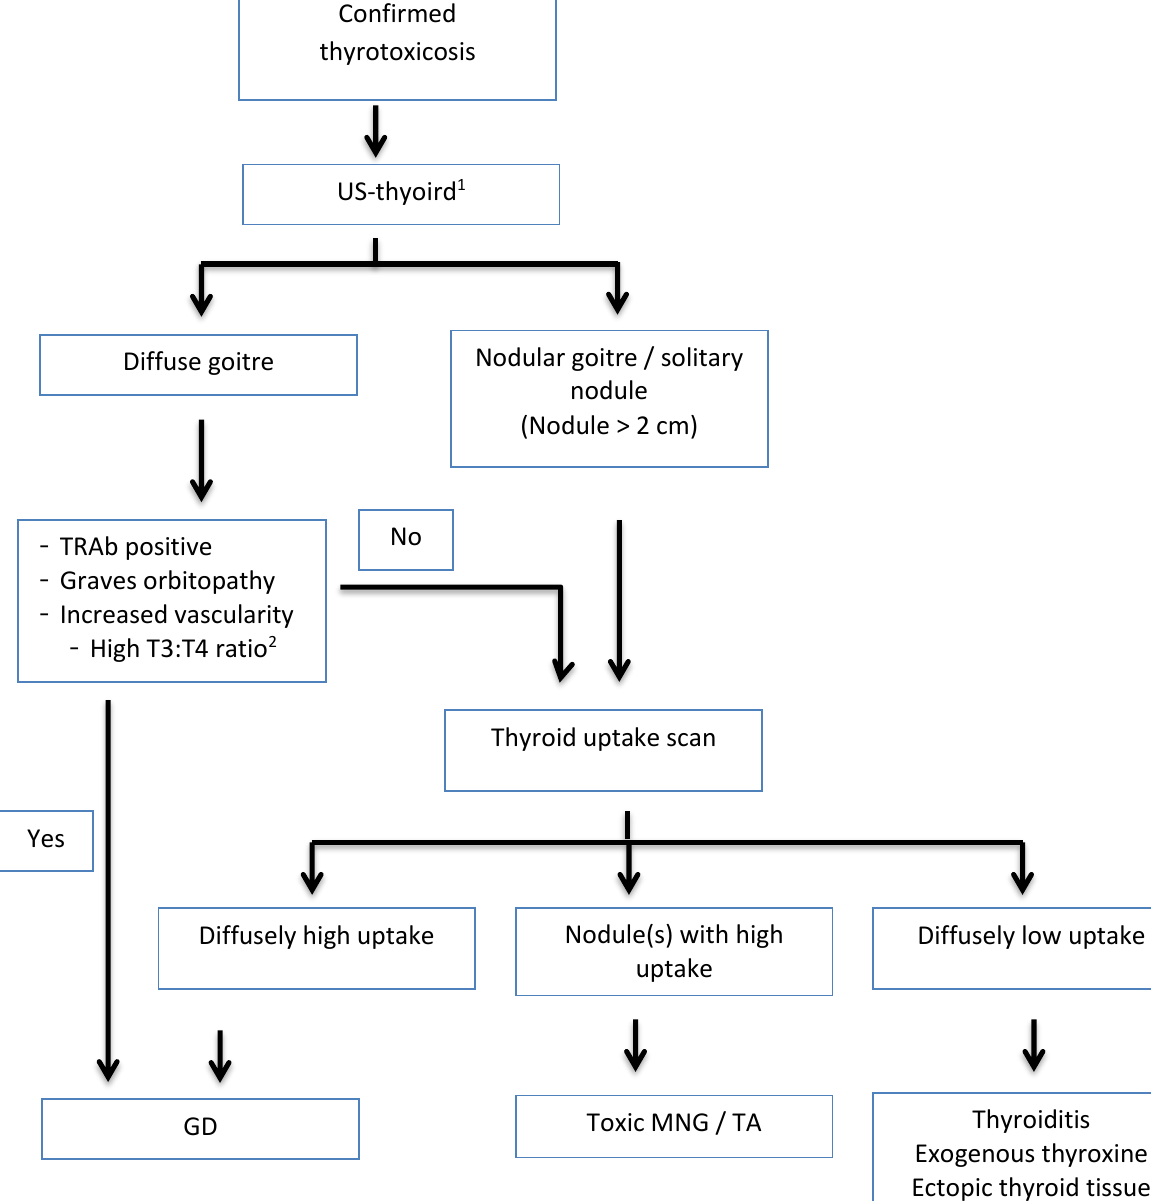
Figure 3.2. Evaluation for aetiology in a patient with